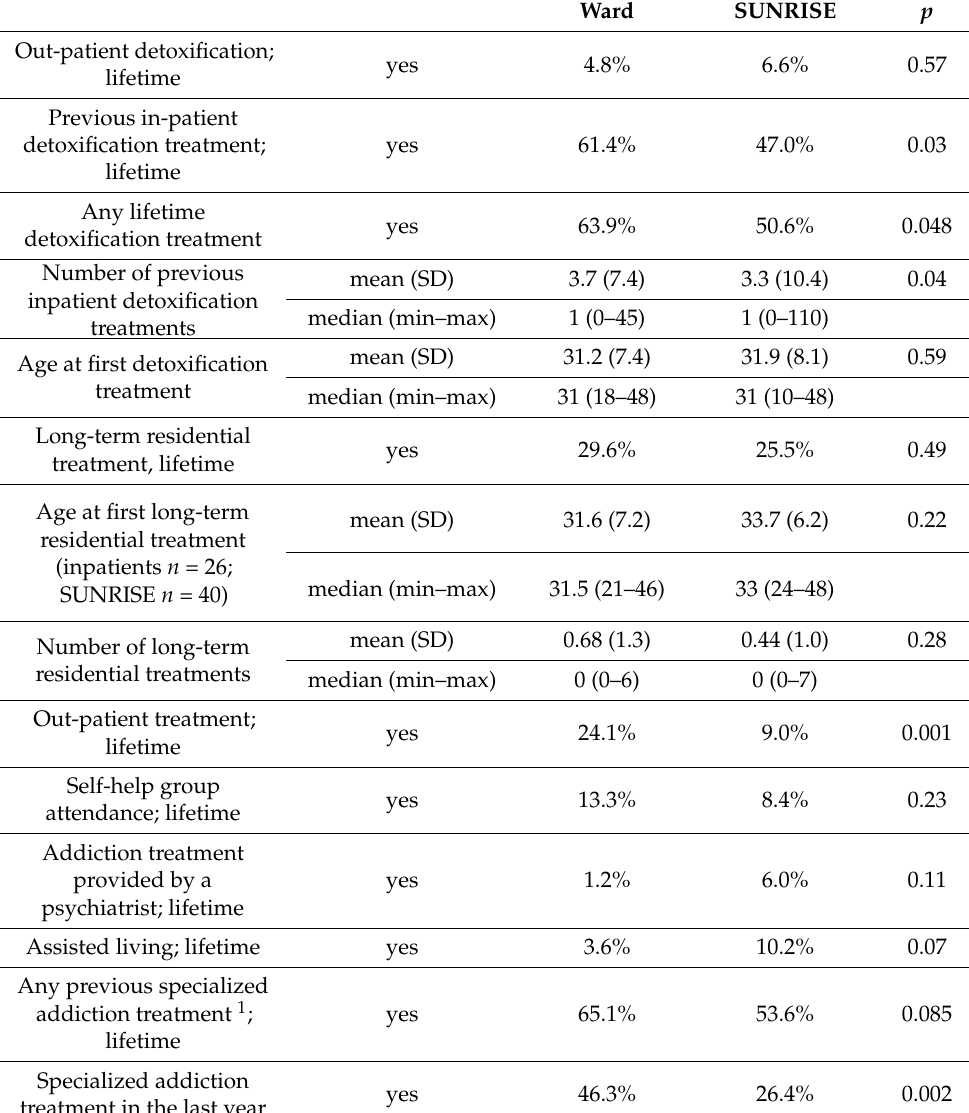
Table 3. Treatment history; comparison between clinical sample (inpatient ward) and unemployment office sample